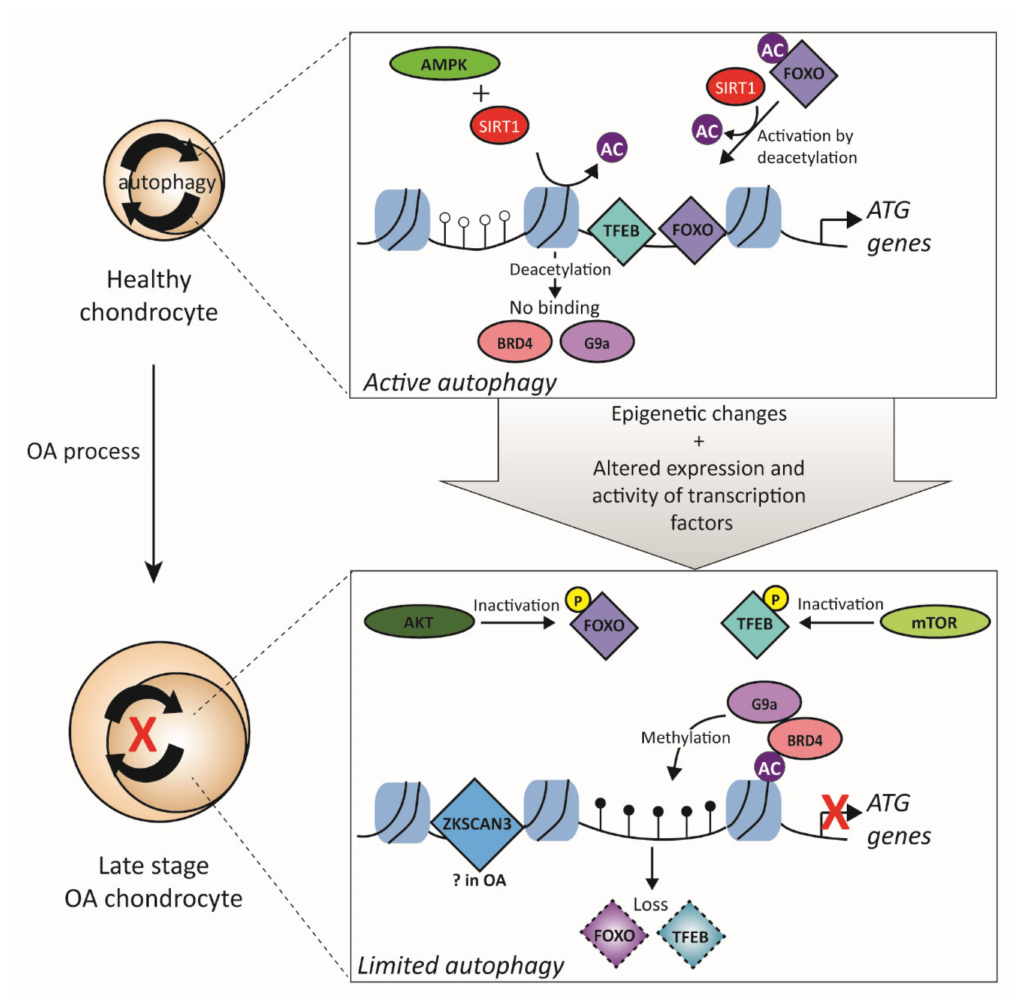
Figure 5. Transcription factors involved in autophagy. In a healthy chondrocyte, there is basal autophagy activity. AMPK and SIRT1 cause the release of BRD4 and the histone methyltransferase G9a via deacetylation of the histones. Furthermore, activating TFs such as TFEB can bind to the promoters of ATG genes and activate transcription. Another TF, FOXO, gets activated by deacetylation by SIRT1 and can, therefore, also activate transcription together with TFEB. In late-stage OA chondrocytes, autophagy is inhibited due to epigenetic changes and altered expression and activity of transcription factors. SIRT1 expression is downregulated in OA and, therefore, histone acetylation is not removed anymore. BRD4 binds to acetylated histone tails and recruits G9a, which hypermethylates the promoters of ATGs. Furthermore, expression of activating TFs such as TFEB and FOXO is downregulated, and their activity is also blocked by phosphorylation by AKT or mTOR. In addition, (probably), inhibitory TFs such as ZKSCAN3 are also recruited to the promoter regions. Together, this results in repression of ATGs transcription and declined autophagy in OA chondrocytes. AMPK = AMP-activated protein kinase; SIRT1 = sirtuin 1; BRD4 = bromodomain-containing protein 4; TFEB = transcription factor EB; ATG = autophagy-related; FOXO = forkhead box transcription factor class O; mTOR = mechanistic target of rapamycin kinase; ZKSCAN3 = zinc-finger protein with KRAB and SCAN domains